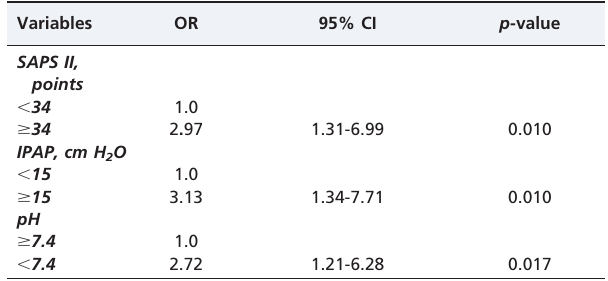
Table 6 - Factors associated with noninvasive ventilation failure – multivariate